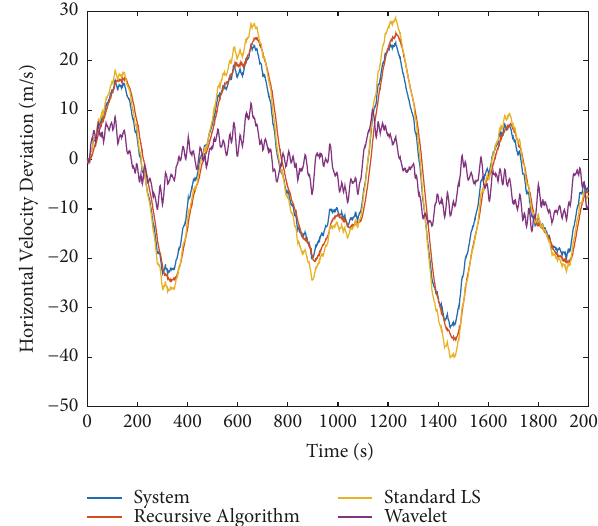
Figure 5: Model identified on full range frequency: Bode plot.